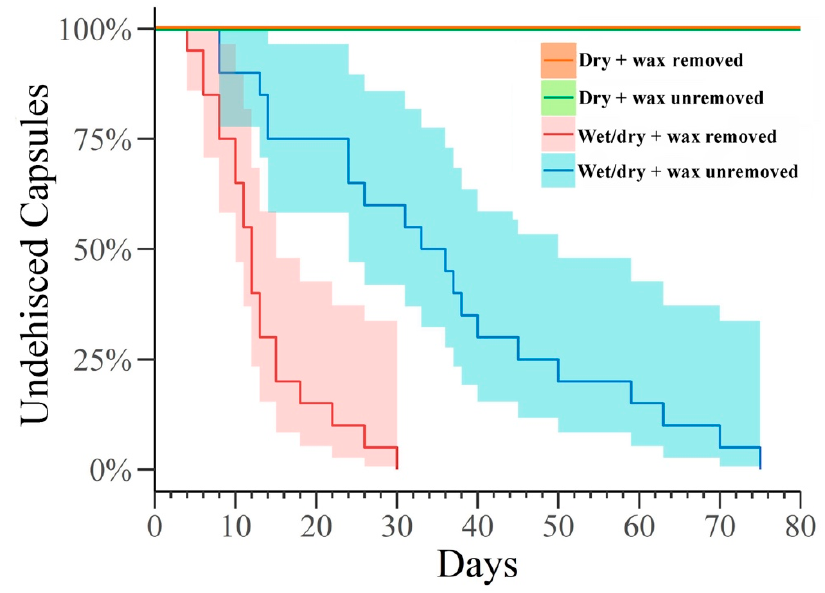
Figure 1. Progressive reduction of the number of undehisced capsules of Primula palinuri . Results of both the effect of cycles of wet and dry conditions and those of wax removal are presented here. Shaded areas represent the 95% confidence interval. Table 1. Analysis of accelerated failure-time model for P. palinuri capsule dehiscence, based on log-normal distribution.